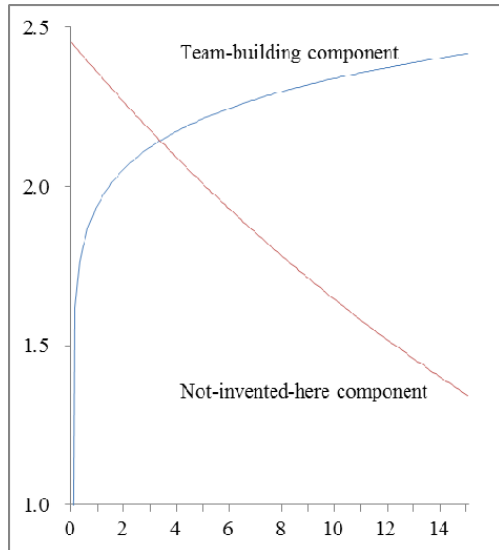
Figure 2. Team-building component and NIH component Note: NIH intersection is adjusted to